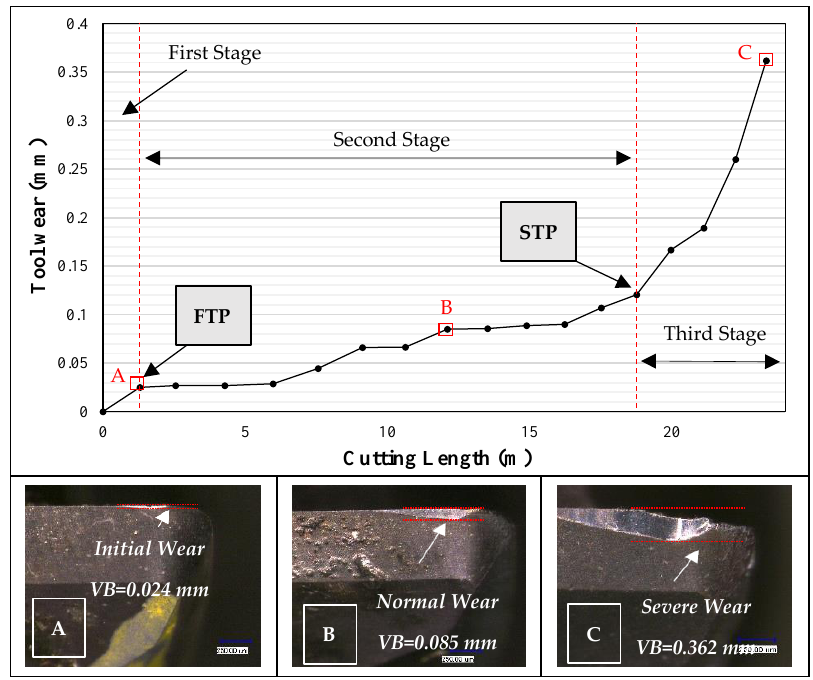
Figure 4. Tool wear evolution curve of the solid carbide end mill for 23.33 m of shoulder milling of AISI 5140 steel block.